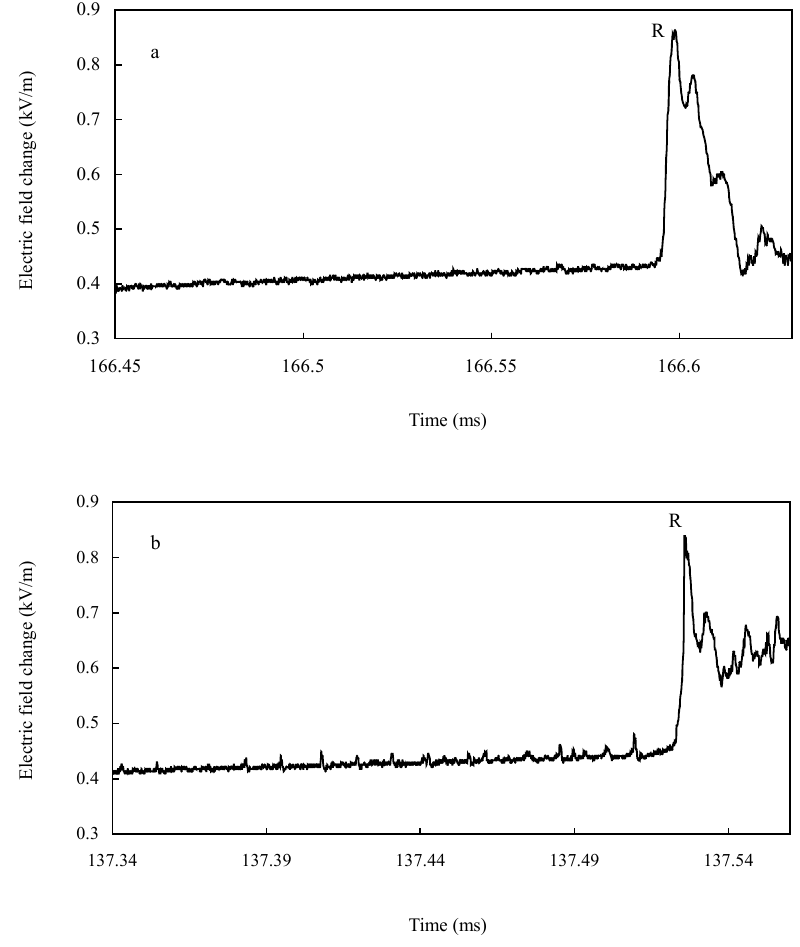
Fig. 6. Electric field produced by a leader just before the initiation of a subsequent return stroke, (a) dart leader occurred at 12:28:41 (Beijing Time), and (b) dart-stepped leader occurred at 13:10:43 (Beijing Time) on 25 July